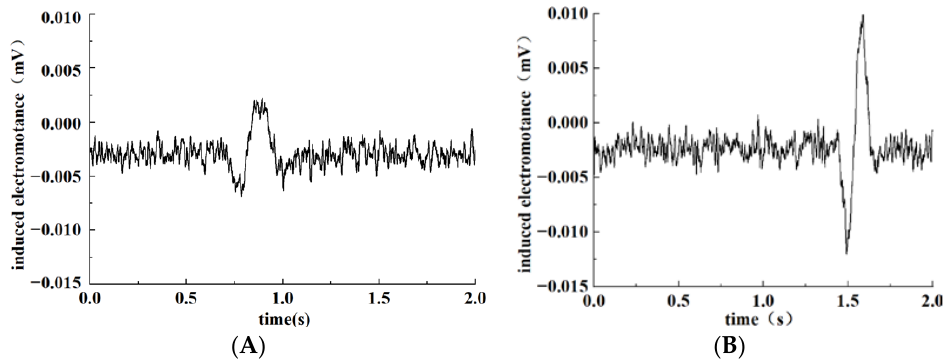
Figure 9. Influence of LC parallel capacitance on particle detection. ( A ) No capacitor in parallel; ( B ) capacitor in parallel.